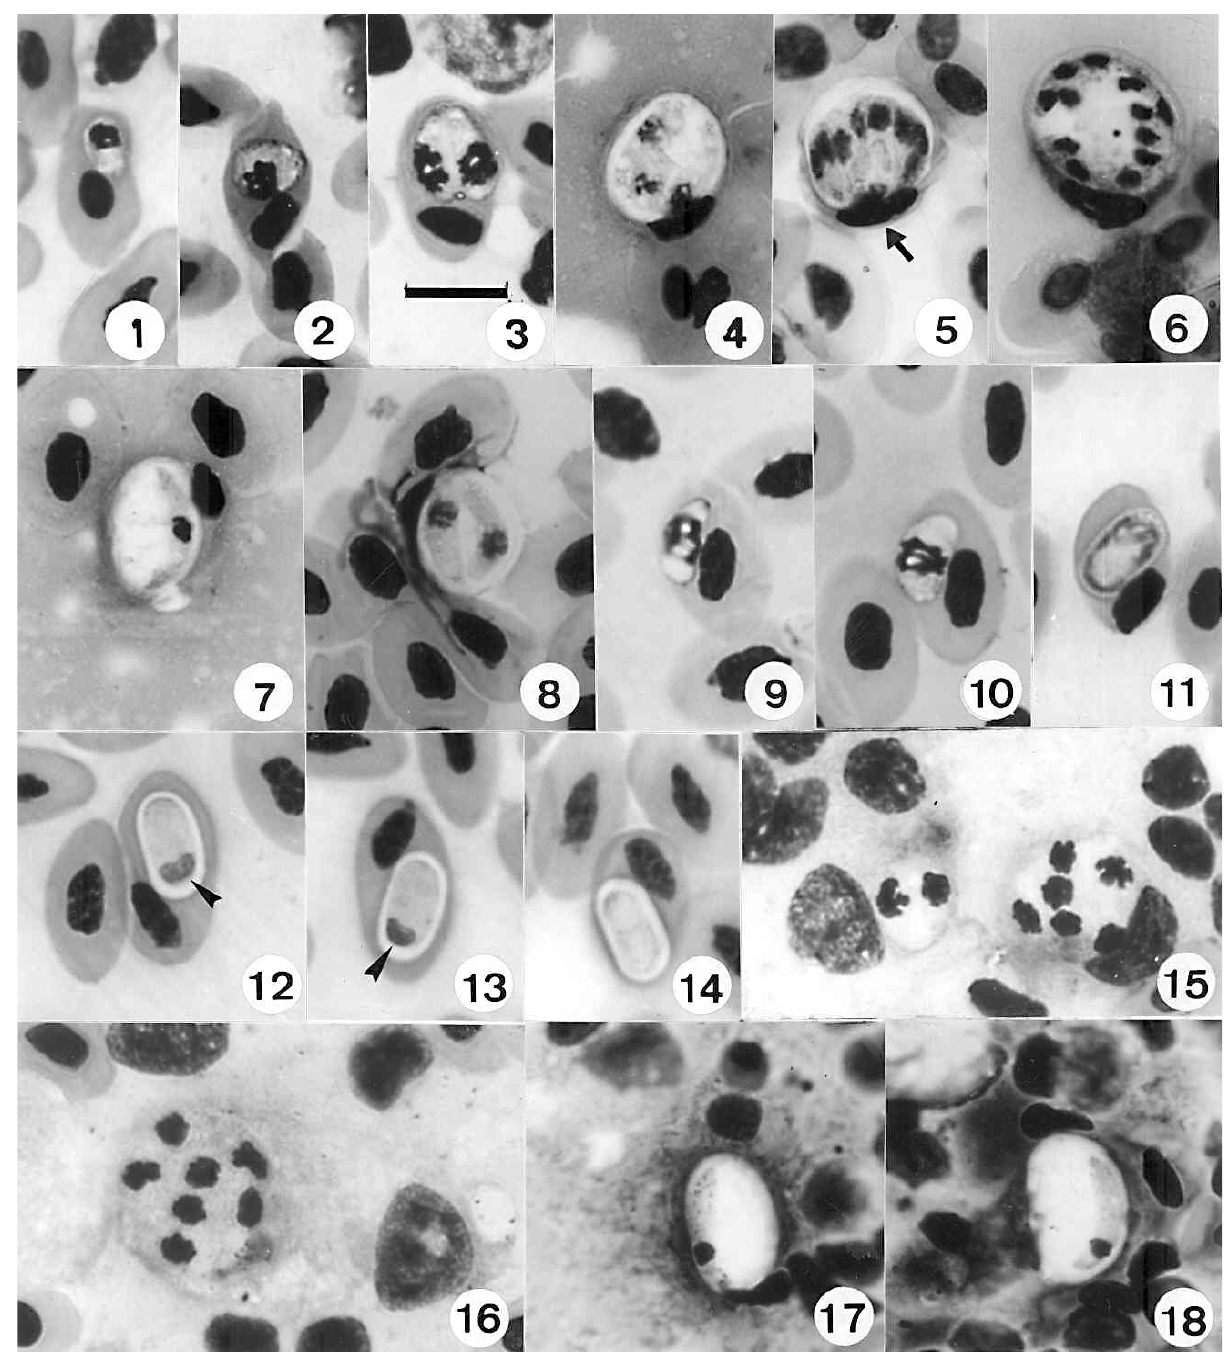
and two cystozoites. Figs 9, 10. Young, intra-erythrocytic gametocytes. Figs 11-14. Encapsulation of mature gametocytes: morphology of the nucleus (arrow heads) suggests the parasite to be doubled-up on itself within the capsule. Figs 15, 16. Exoerythrocytic schizonts in cells of the R-E system in the liver. Figs 17, 18. Monozoic cysts in the spleen. Giemsa-stained smears. Bar in Figure 3 = 10 µm and applies to all other